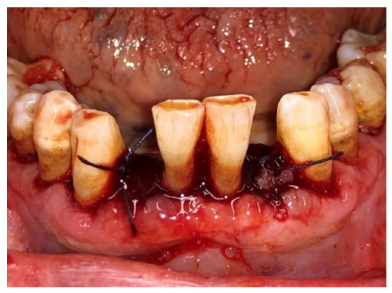
Figure 4. Immediate post-surgical, Group